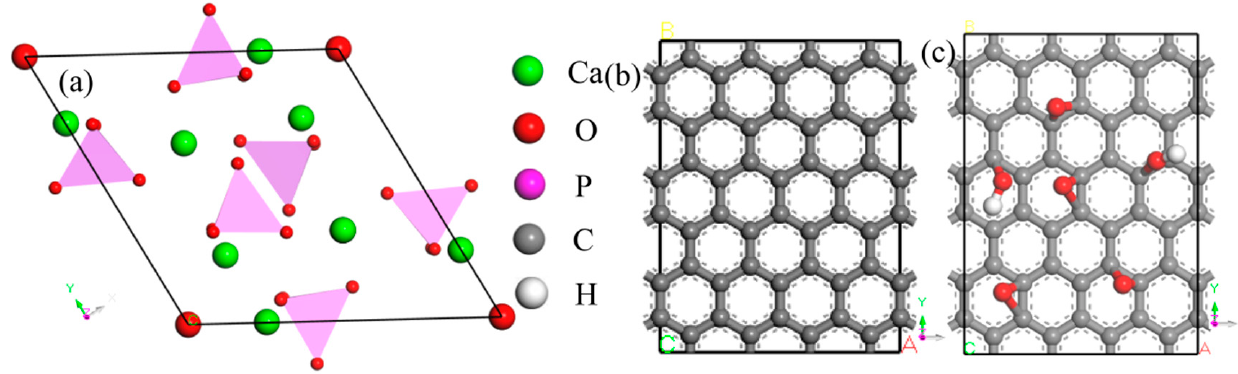
Figure 1. The models of ( a )HA, ( b )G, ( c )GO.